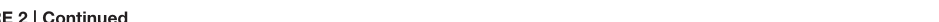
FIGURE 2 | Continued indicated by periods. Substrate discrimination residues at the aromatic/arginine (ar/R) constriction site are indicated with open triangles. Glycerol binding sites are indicated with shaded triangles. The asparagine–proline–alanine (NPA) motifs are underlined. Potential phosphorylation sites are indicated by shaded arrows. The predicted transmembrane domains (TM1–6) of Aqp3 of P. annectens are indicated by open boxes and were predicted using MEMSATS & MEMSAT-SVA provided by PSIPRED protein structure prediction